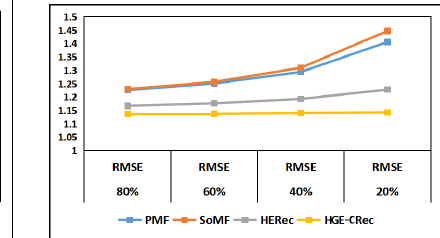
( b ) Comparison of RMSE with the change in the training rate on dataset CNPC